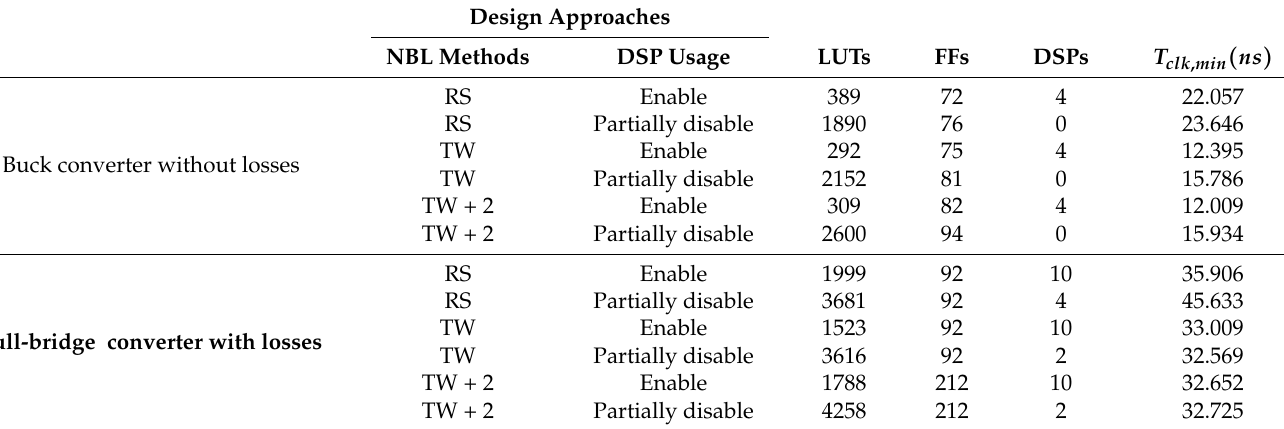
Table 5. HLS synthesis results for fixed-point using Vivado tool.